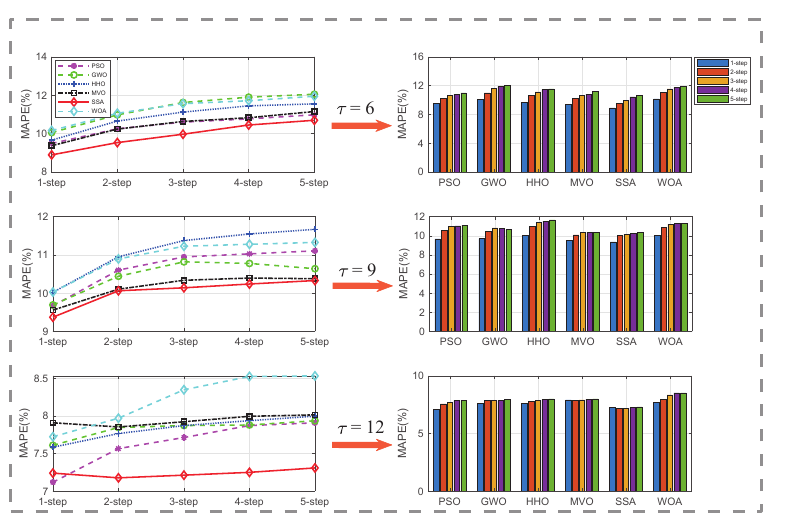
Figure 20. MAPEs of multi-step